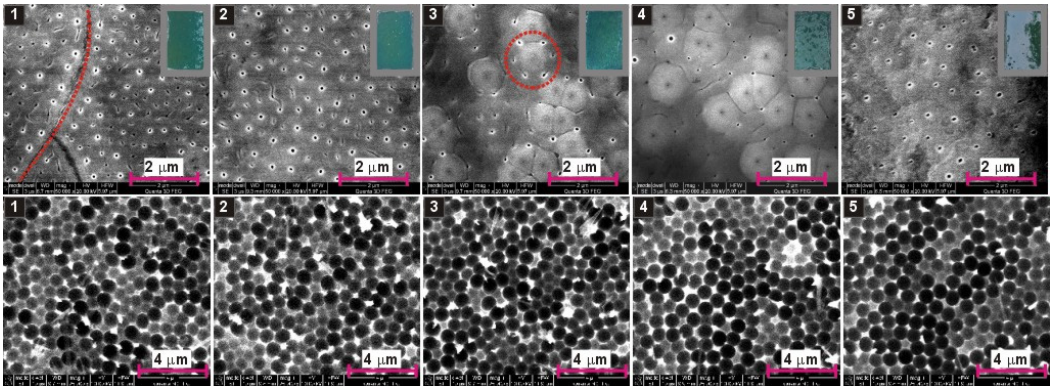
Figure 6. SEM images of AAO—top view (upper row) and nanoconcaves left on aluminum surface after AAO dissolution (lower row) for the samples anodized for 8 h, at 5 °C, 300 V, five times in a row in the same 0.15 M malic acid solution; in the right corners of the SEM images presented in the upper row, photographs of the samples after anodization are shown (in grey frames).